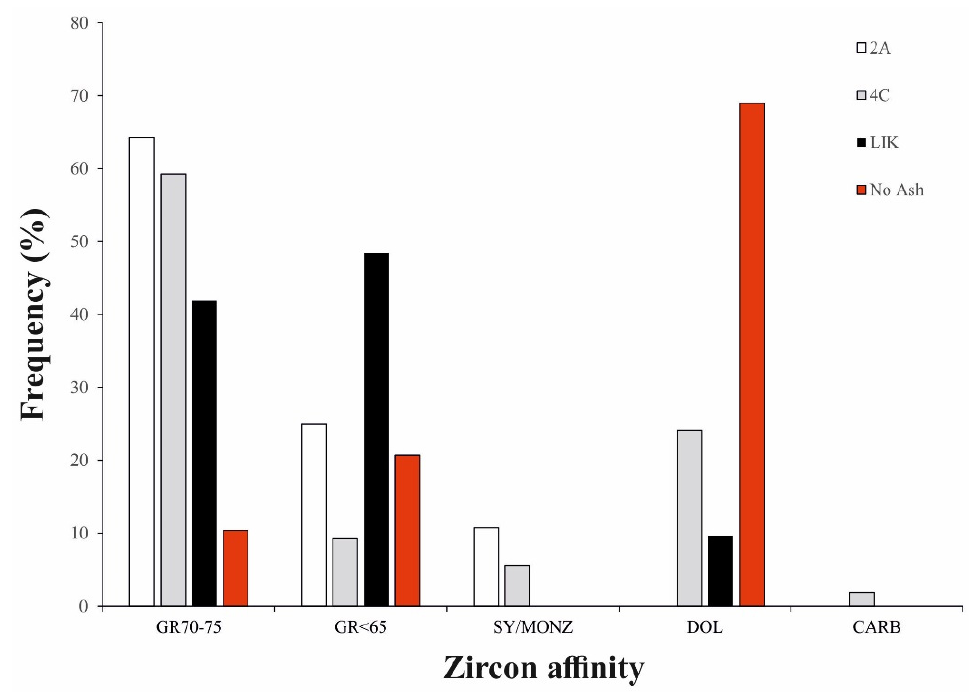
Figure 12. Frequency distributions of zircons according to the possible sources, as determined using the classification tree diagram by [27]. GR70–75: granitoids with about 70–75% SiO 2 ; GR < 65: granitoids with less than 65% SiO 2 ; SY/MONZ: syenites and monzonites; DOL: dolerites; CARB: carbonatites.